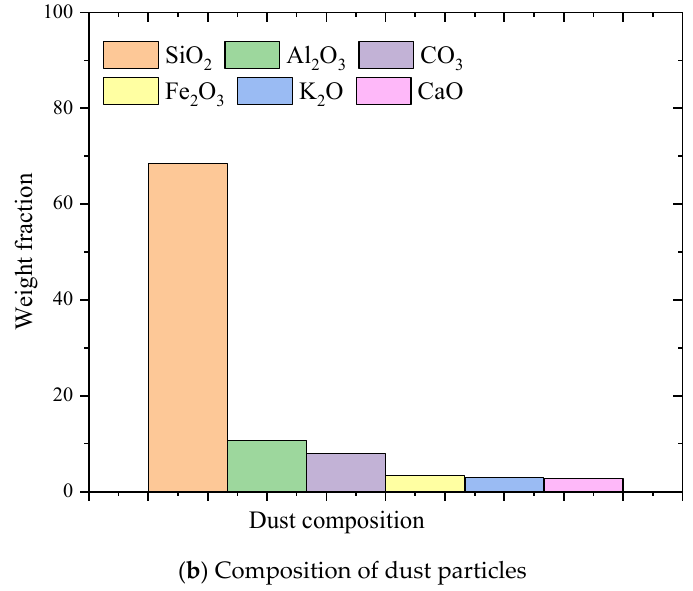
Figure 2. Cumulative volume fraction and composition of dust particles.